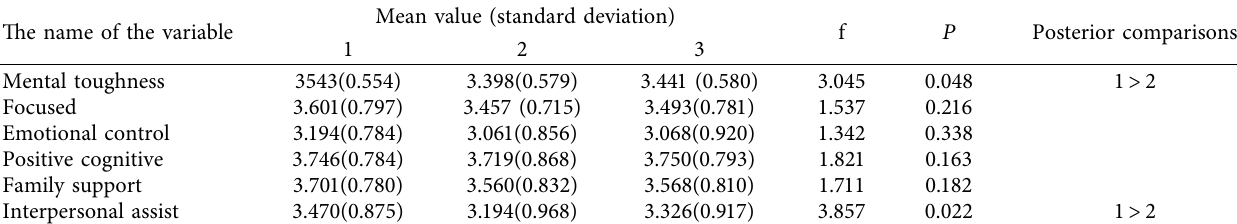
Table 3: Summary of the difference analysis of mental toughness among students of different